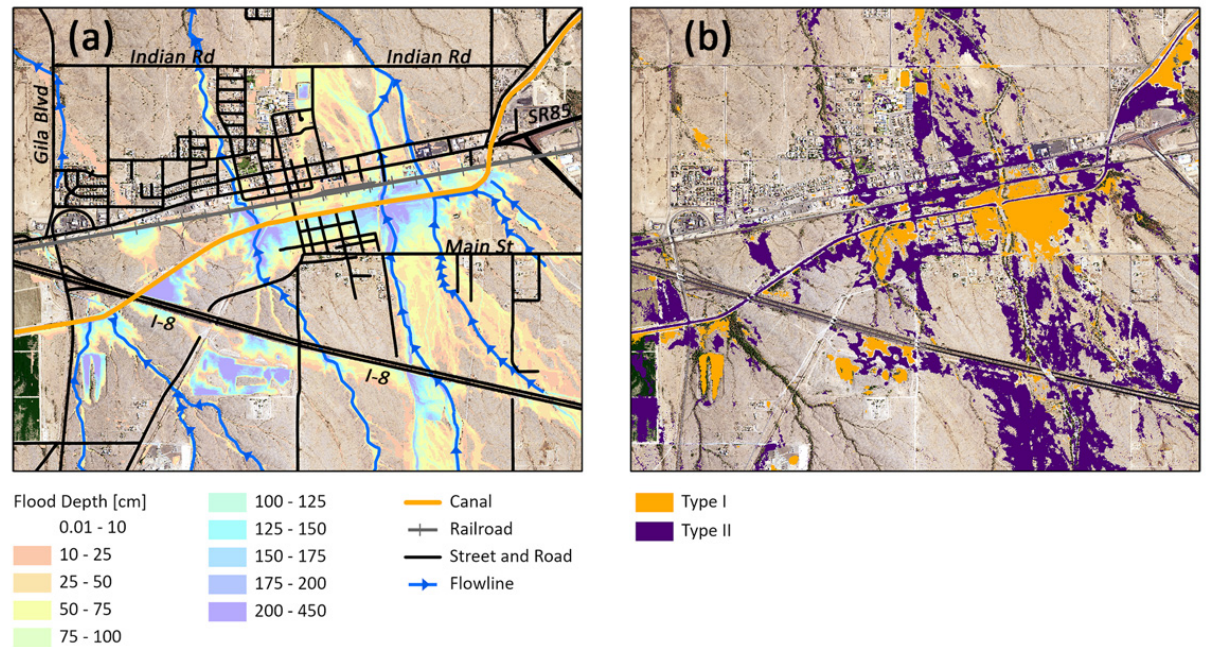
Figure 5. Flood extents around the town of Gila Bend from different sources. ( a ) Flood depth under 100-year return period simulated by FLO-2D, with streets, roads, railroad, canal, and flowlines labeled for reference. ( b ) Flood extent for two types of flooded areas derived from CubeSat imagery.